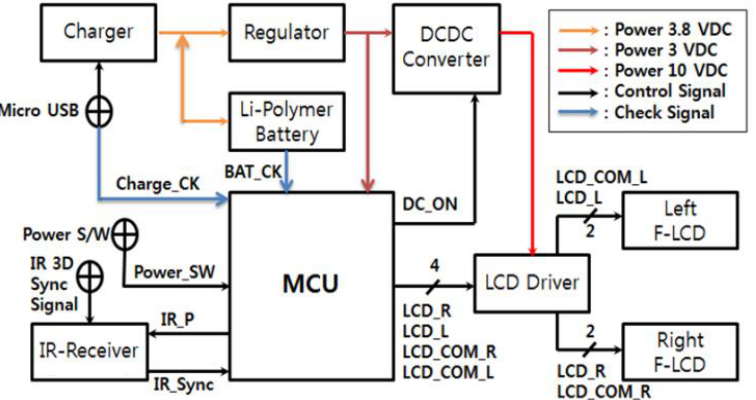
Figure 6. Block diagram for the active shutter glasses with the flexible liquid crystal lens.